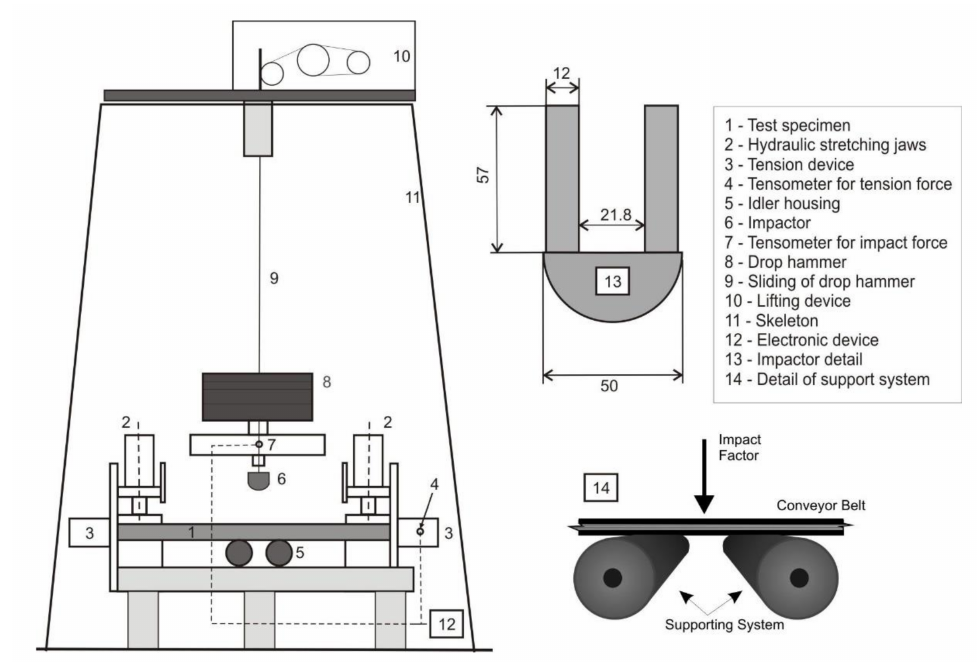
Figure 1. Test equipment